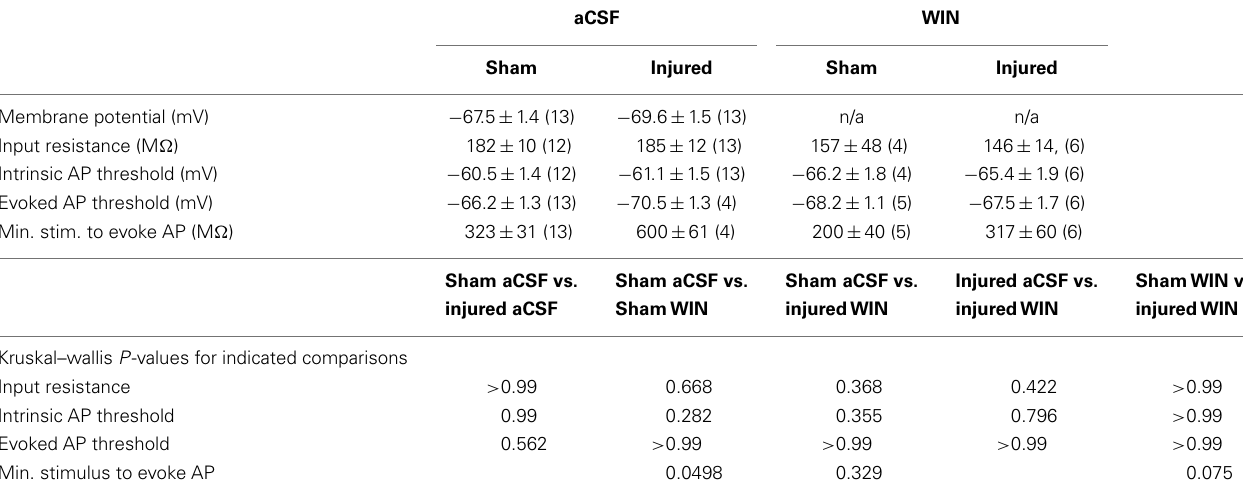
Table 1 | Intrinsic membrane properties and excitability of CA1 pyramidal neurons